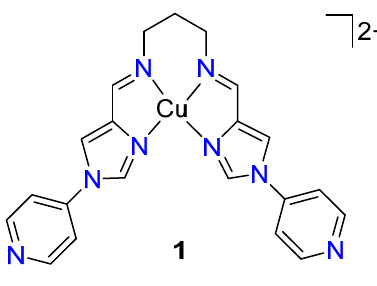
Figure 1. Structural details of the cubic cation in [Pd 4 (CuL) 8 (DMSO) 2 (H 2 O) 6 ](NO 3 ) 24 ( 2 ),